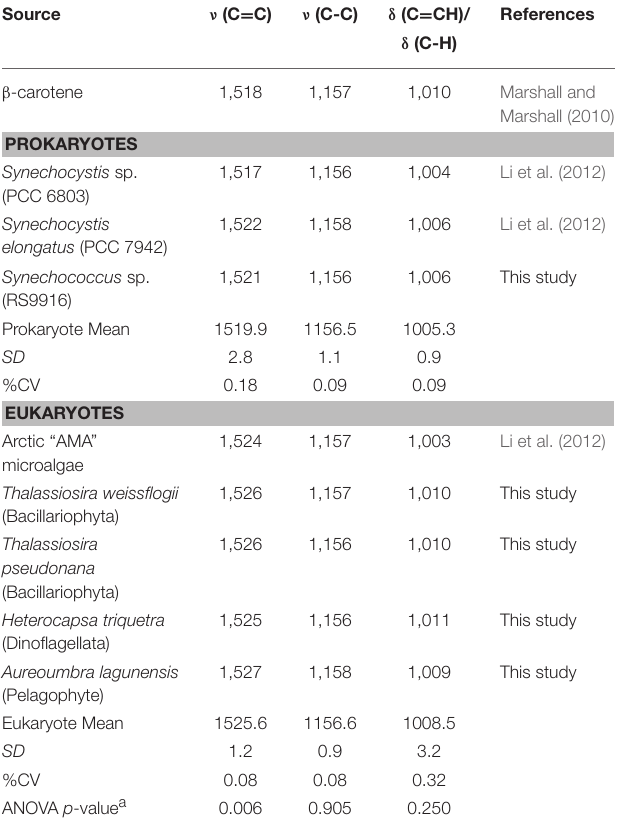
TABLE 2 | Variability in major wavenumber positions (cm − 1 ) for carotenoid peaks in photosynthetic microorganisms grown under natural stable isotope